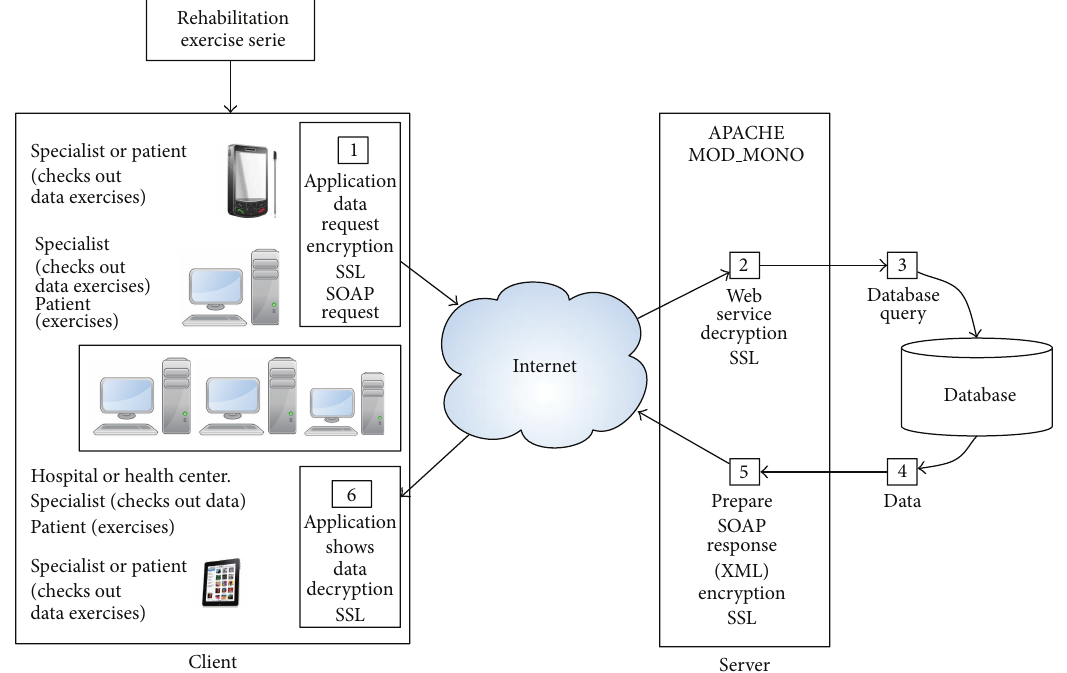
Figure 4: Scheme of eFisioTrack’s software components and where they are